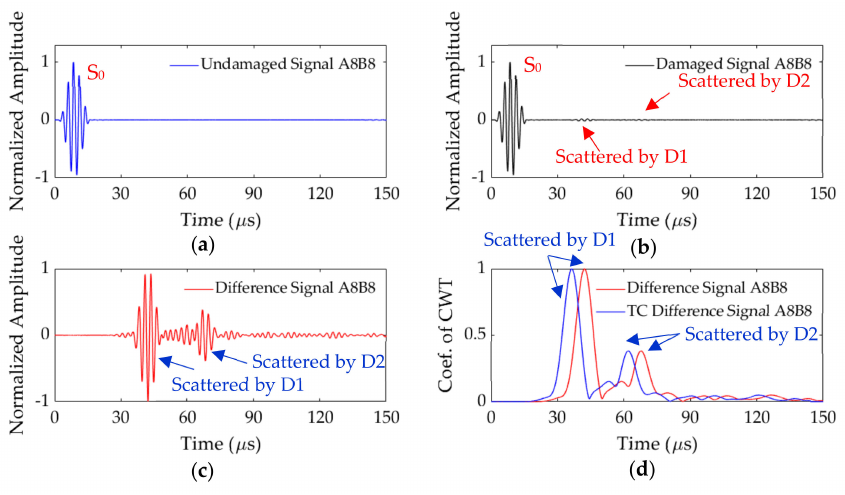
Figure 17. Signals for sensing path A8B8 in multiple damage scenario: ( a ) undamaged; ( b ) damaged; ( c ) di ff erence; ( d ) coe ffi cient of CWT with and without time compensation.